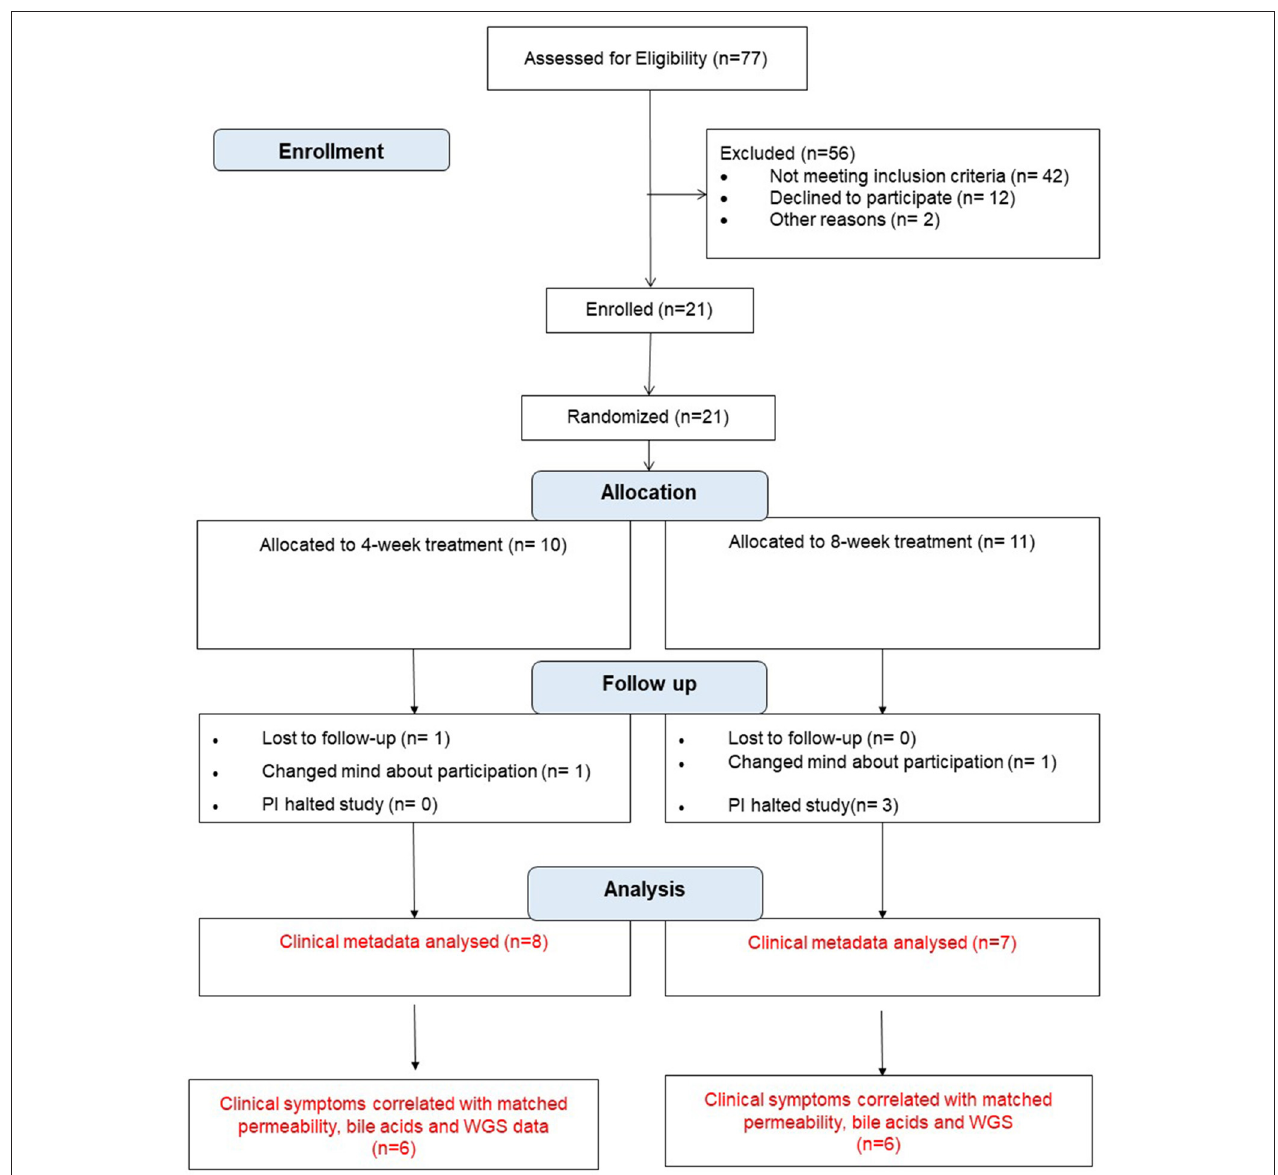
FIGURE 1 | Consort diagram of probiotic VSL#3 treatment in patients with irritable bowel syndrome.